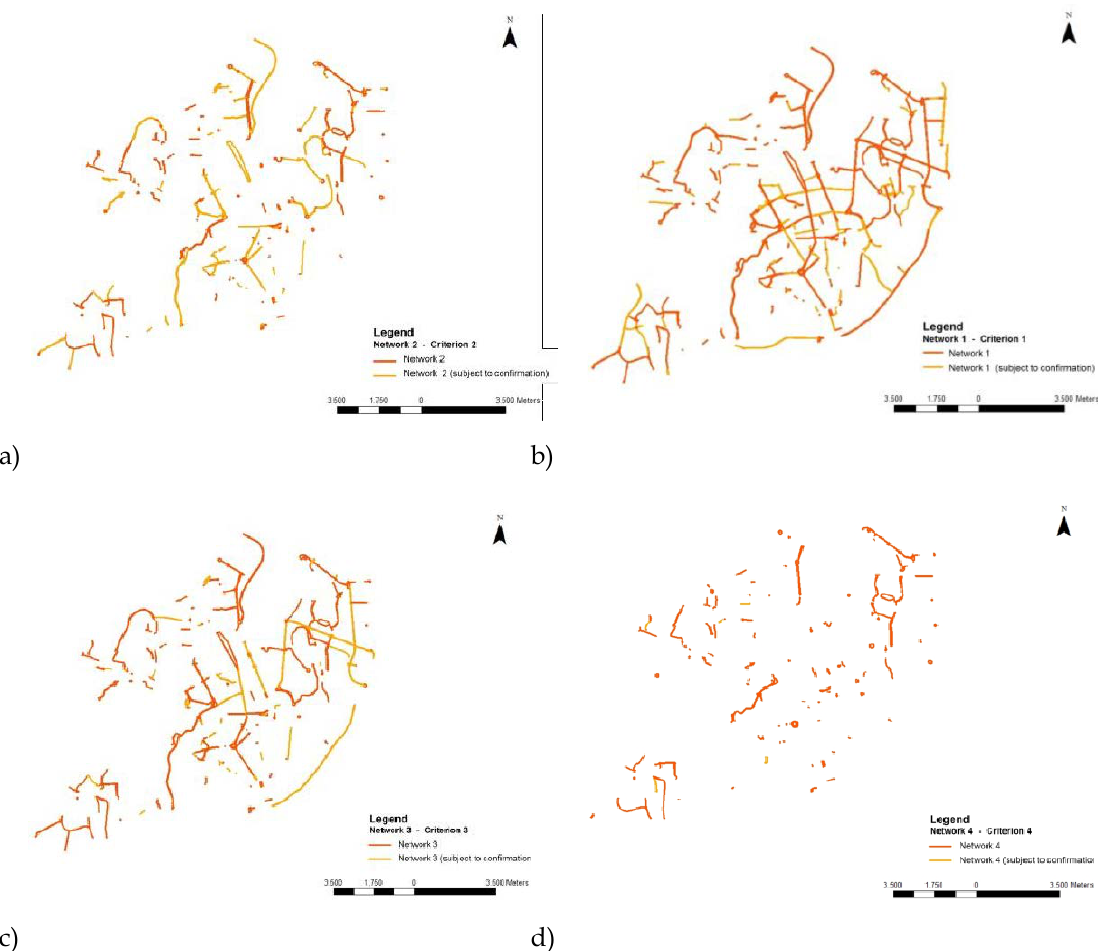
Figure 5. Road network rearrangement for cycle network according to different criteria: (a-d) for criteria 1 to 4,